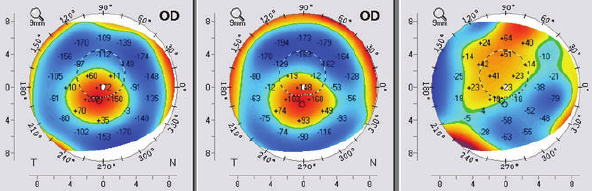
Figure 11: Pre- and postoperative Scheimpflug tomography (poste- rior elevation map), right